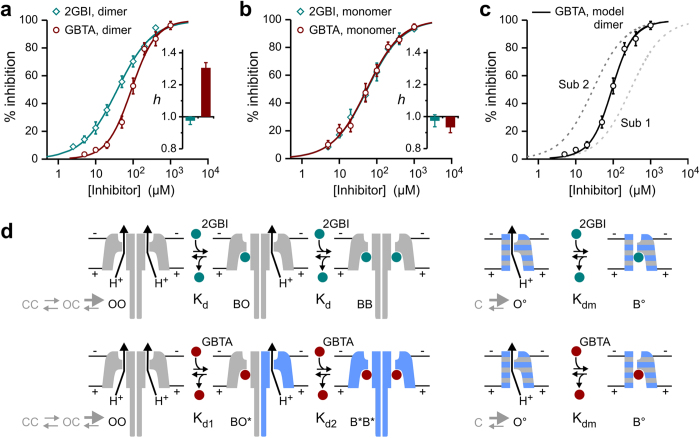
Guanidinothiazole derivatives bind to the Hv1 dimer in a cooperative way.(a,b) Concentration dependences of inhibition of dimeric and monomeric Hv1 by compounds 2GBI and GBTA. Each point represents the average inhibition from 3 to 8 measurements ± S.D. Curve lines are Hill fits. Hill coefficients (h) shown in inset histograms were determined from fits reported in Supplementary Figs 3 and 4. The concentration response for GBTA shown in (a) is the same as in Fig. 1c. For apparent Kd values see Supplementary Table 1. (c) Modeling of cooperative binding of GBTA to dimeric Hv1. Solid black line represents the fit of the experimental data by equation (6), which describes the binding model shown in (d). Dotted lines marked as Sub 1 and Sub 2 represent the bimolecular association-dissociation equilibrium curves for the first and second binding events, respectively (Sub 1: OO + B ⇄ BO*, Kd1 = 290 ± 70 μM; Sub 2: BO* + B ⇄ B*O*, Kd2 = 29.3 ± 2.5 μM). (d) Schematic representation of the proposed mechanism of Hv1 block. In the case of GBTA, binding to one open subunit, increases the affinity of the neighboring open subunit (Kd2 < Kd1). Subunits are gray when in the low affinity state and blue when in the high affinity state. For the binding of GBTA to the monomerized Hv1, the dissociation constant of the reaction: O° + B ⇄ B° has a value between Kd1 and Kd2, but closer to the latter (gray-blue stripes indicate intermediate affinity).